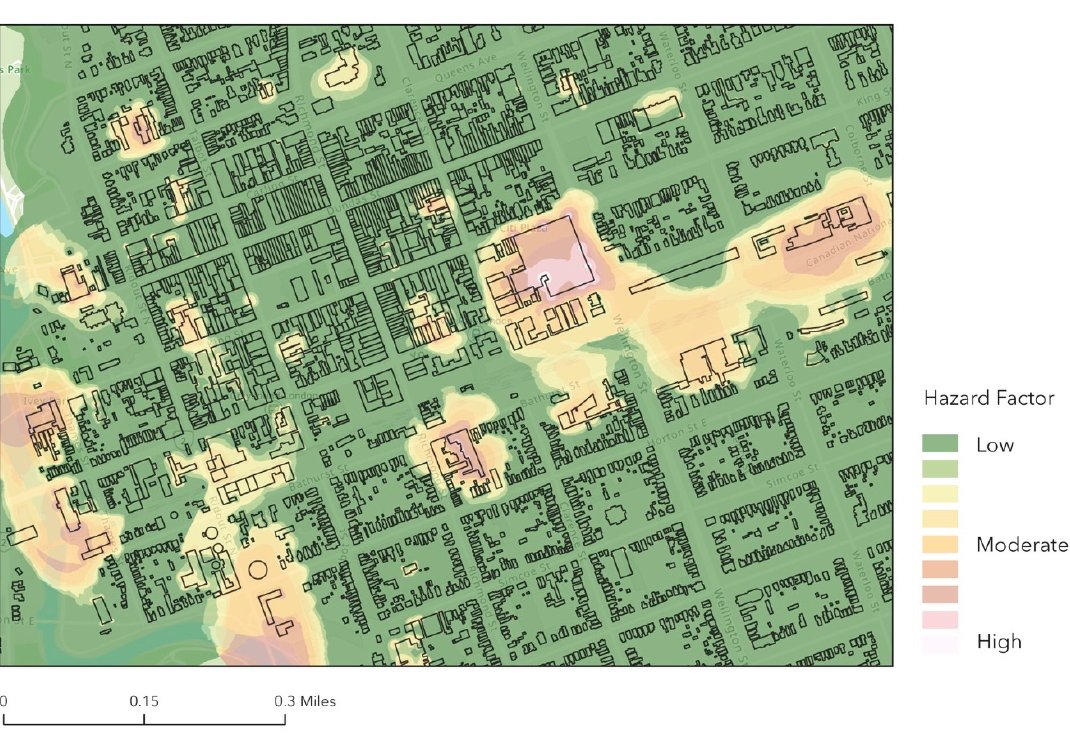
Figure 5. Detail of acute hazard map of London, 1915. Industrial hazards present in London at various time periods can be visualized at the city scale within the London HSDI by applying an inverse-distance weighting (IDW) spatial interpolation to the IPPS-derived hazard factors appended to the London HSDI Built Environment (BE) data. This image shows the distribution of industrial hazards across a large section of London in 1915. Image by author.